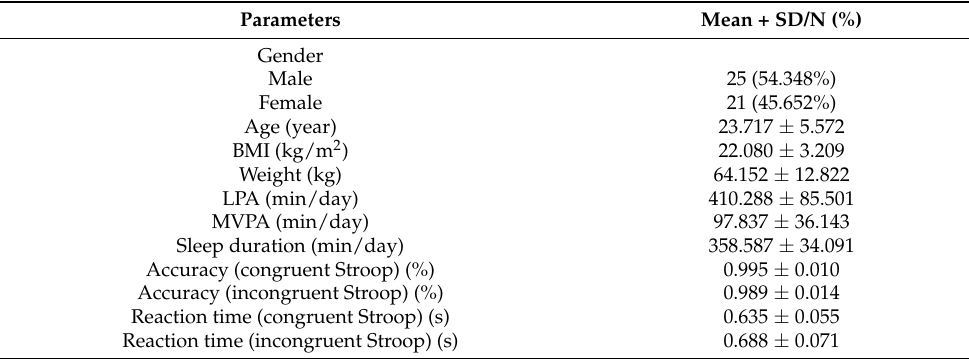
Table 1. Demographic information of study